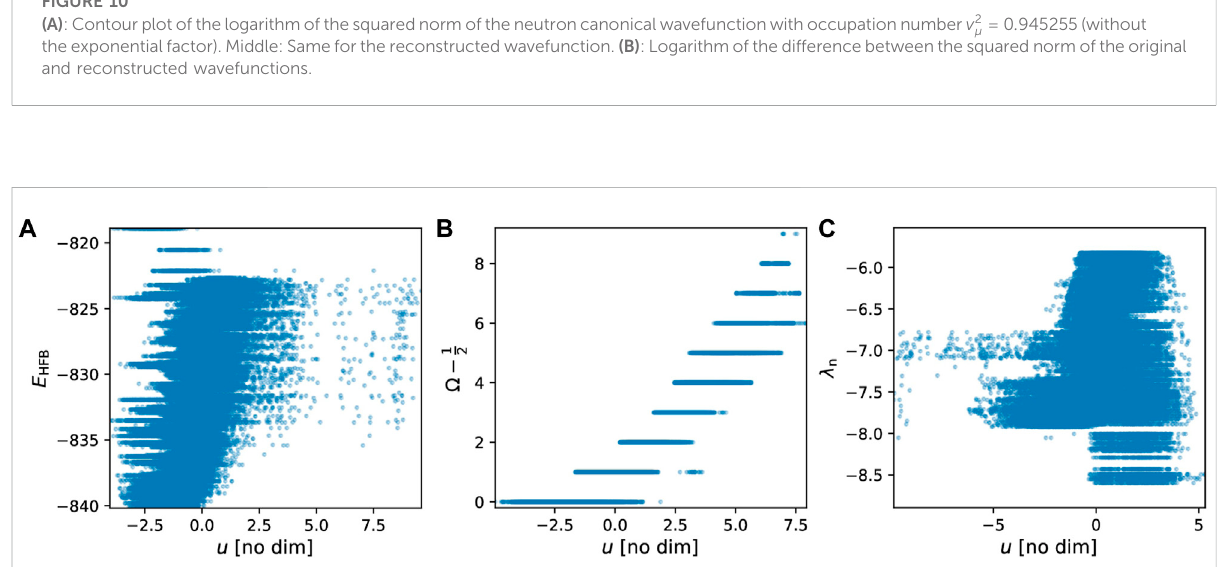
FIGURE 11 One-dimensional projections of the D -dimensional linear fi t for the total energy E HFB (A) , the projection Ω of the canonical state (B) and the neutron Fermi energy λ n (C) . Each point represents one of these quantities for a canonical wavefunction μ and a point q in the collective